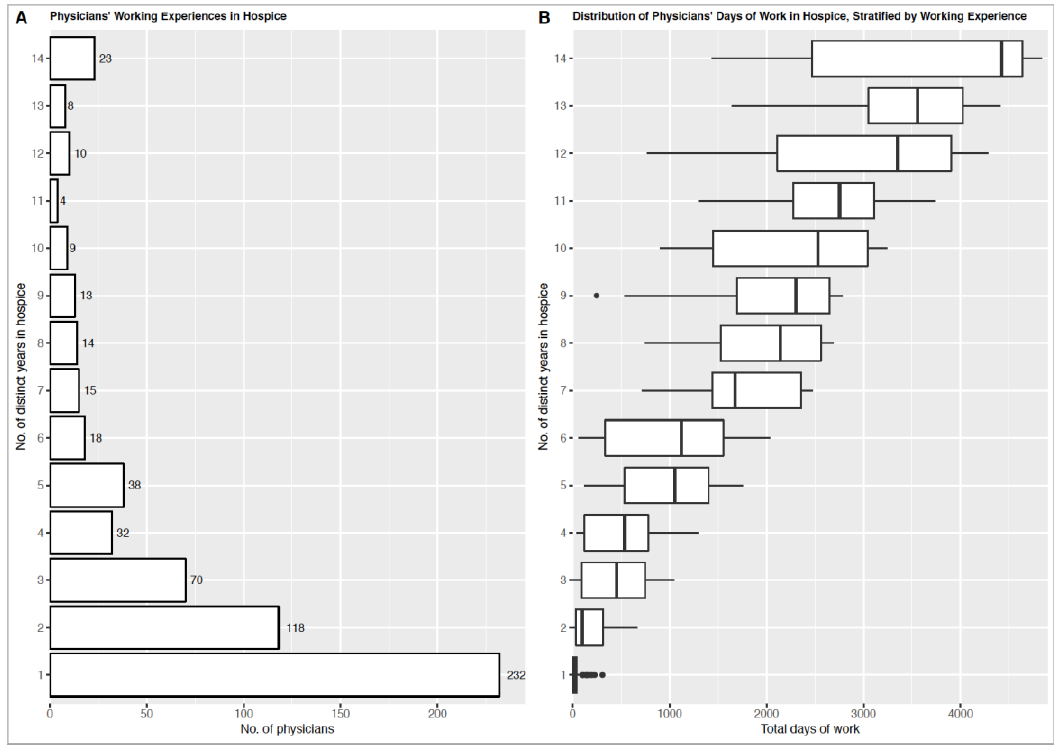
Figure 1. ( A ) The numbers of physicians with distinct years of HPM work experience; ( B ) The distribution of physicians’ work days, stratified by distinct years of HPM work experience.